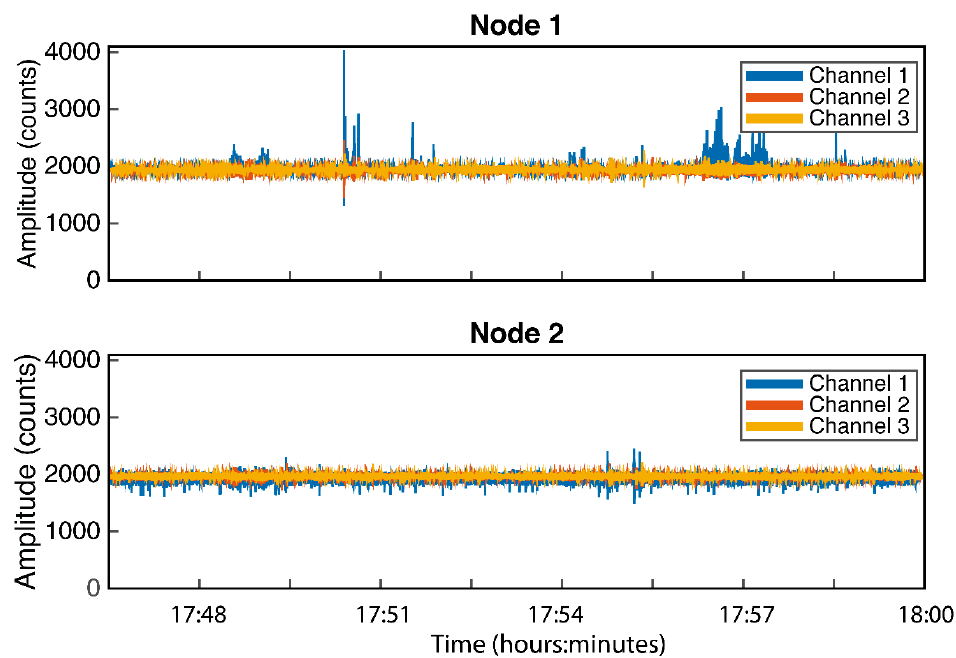
Figure 20. Example of 15 min.